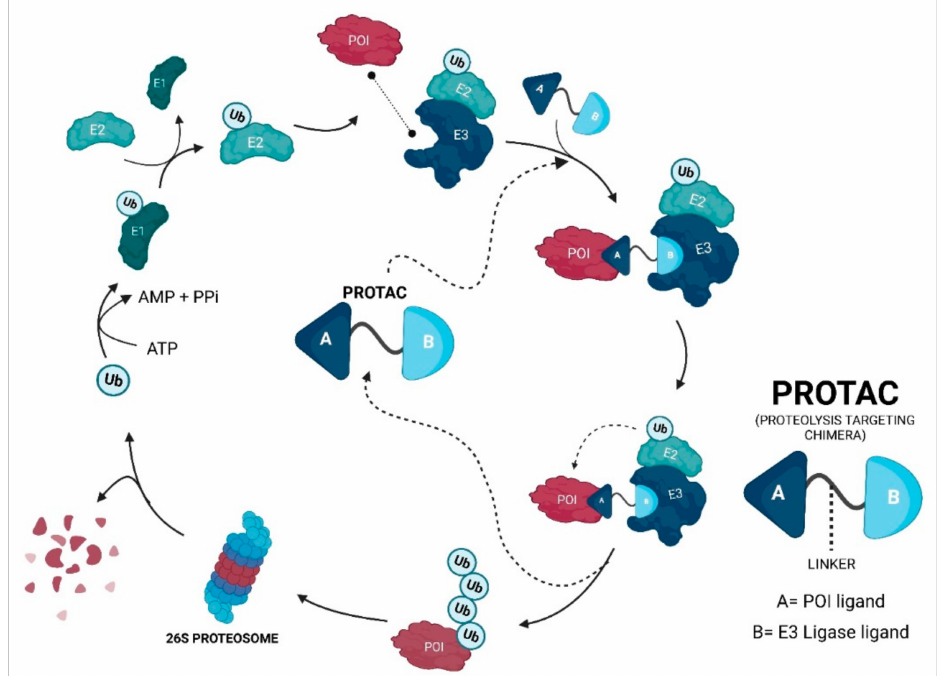
Figure 2. The PROTACs mechanism of action—PROTAC promotes the simultaneous and artificial binding between the protein of interest (POI) and the chosen E3 ligase, forming a stable ternary complex. This promotes the ubiquitination of the POI and the subsequent degradation by the UPS. After the degradation of a target molecule, PROTAC has the ability to re-link with other POI molecules in case it has ligands that reversibly bind to the target and restart a whole new cycle of degradation